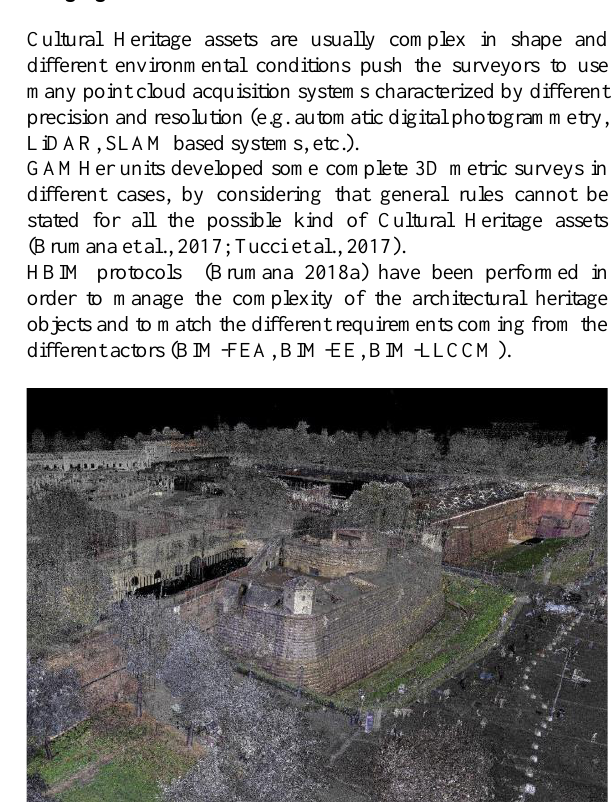
Figure 11. Point cloud generated by different sensors (Tucci et al., 2017)